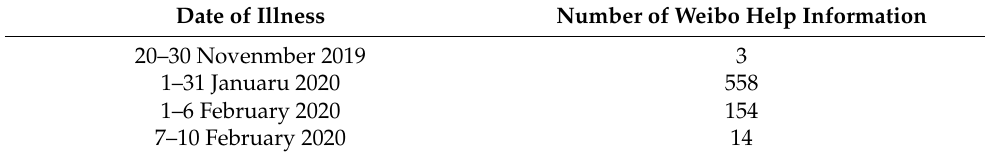
Table 2. Statistics of onset